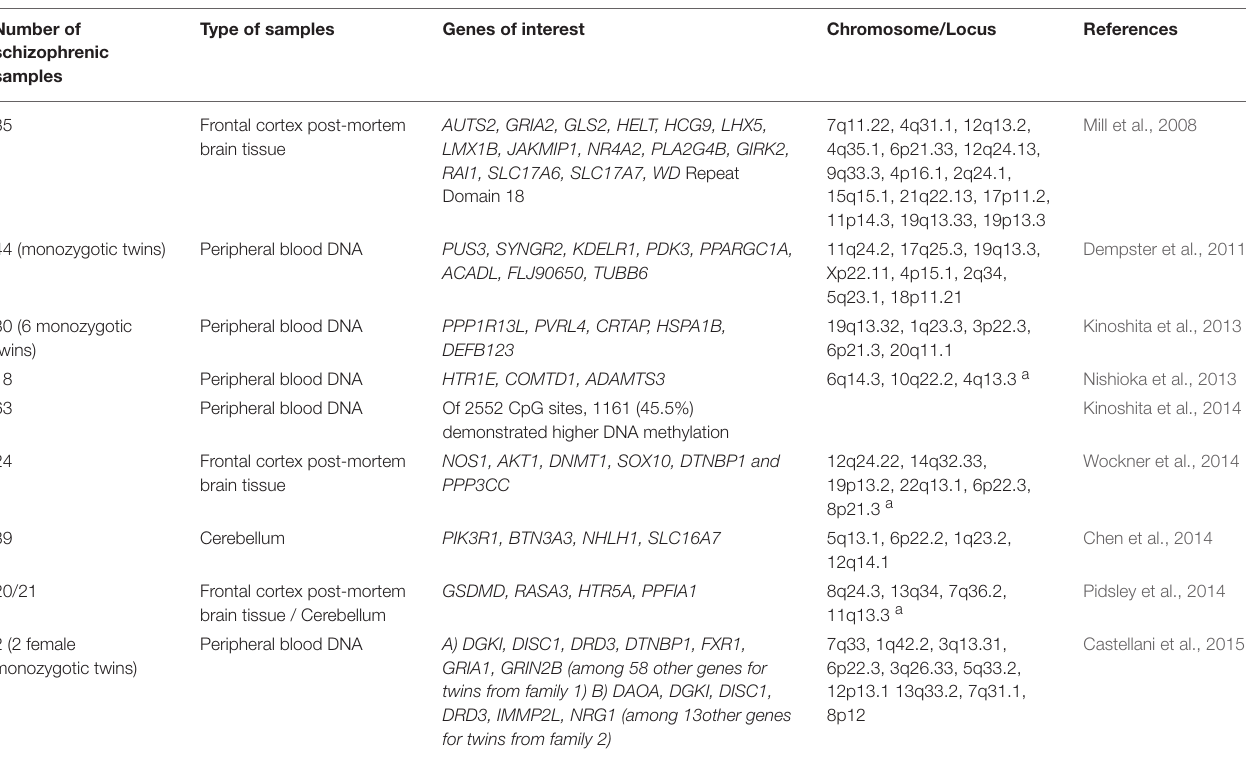
TABLE 2 | Epigenome-wide association studies in schizophrenia. Number of